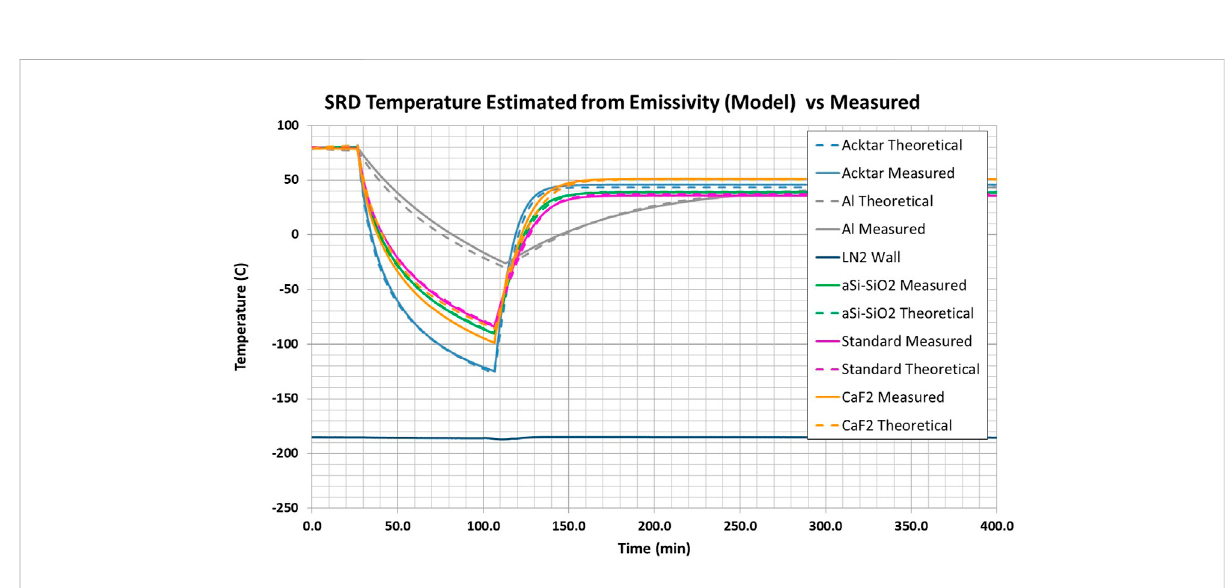
FIGURE 10 Cool-down and heating curve for Test 4 SRD transient analysis.